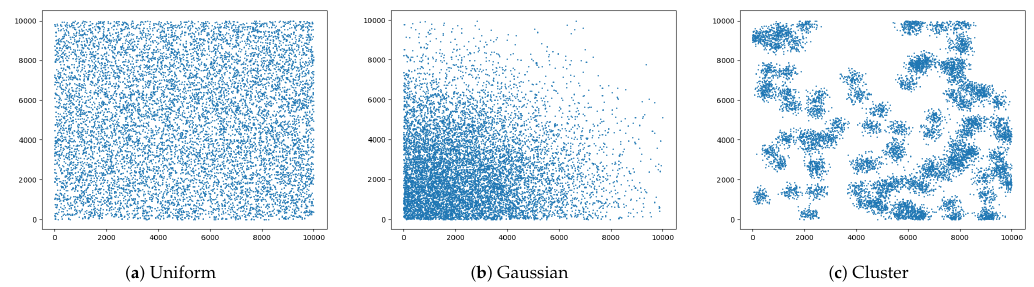
Figure 5. Projections of three differently distributed data in two